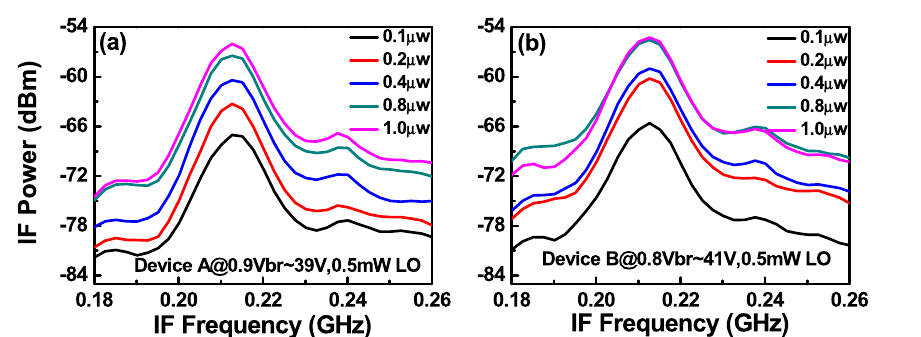
Figure 12. Measured IF spectra under fixed 0.5mW LO power with different received powers for. ( a ) Device A at 0.9V br . ( b ) Device B at 0.8V br